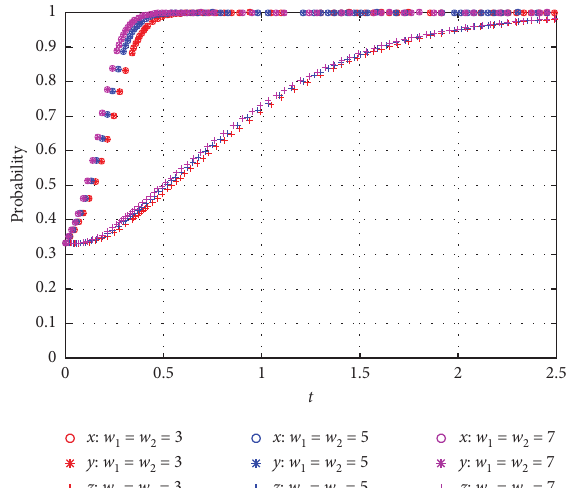
Figure 9: Evolution paths of scenario 4 under different sunk costs and reputation.